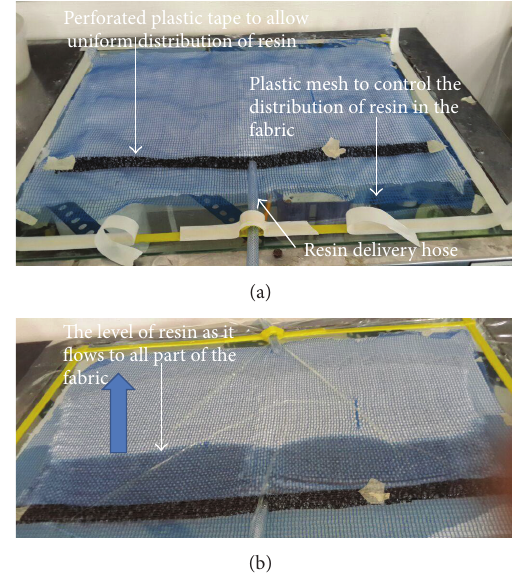
Figure 3: Vacuum infusion process. (a) Interwoven fabric in the mould tool before resin impregnation. (b) Interwoven fabric in the mould tool during resin